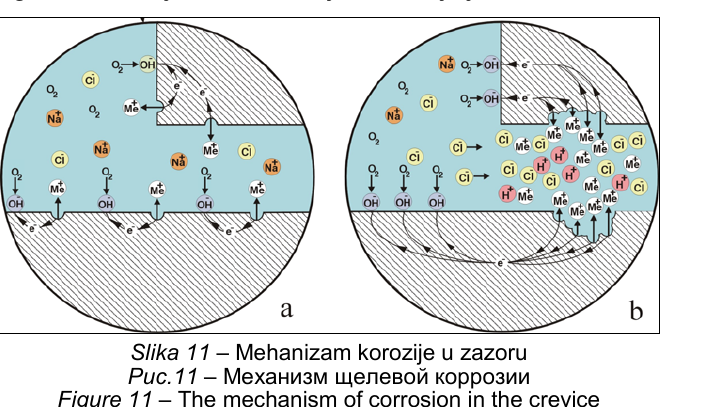
Figure 11 – The mechanism of corrosion in the crevice